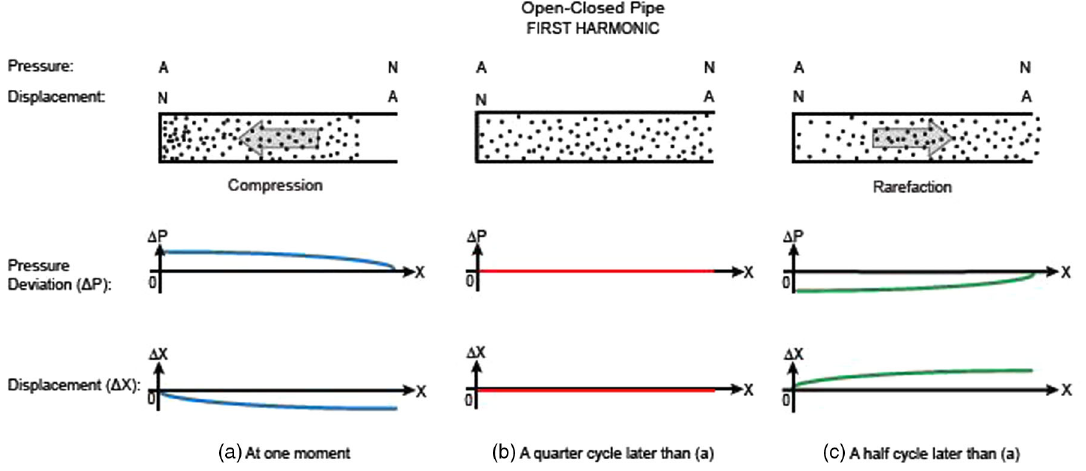
FIG. 12. First harmonic sound standing wave in an open-closed pipe.